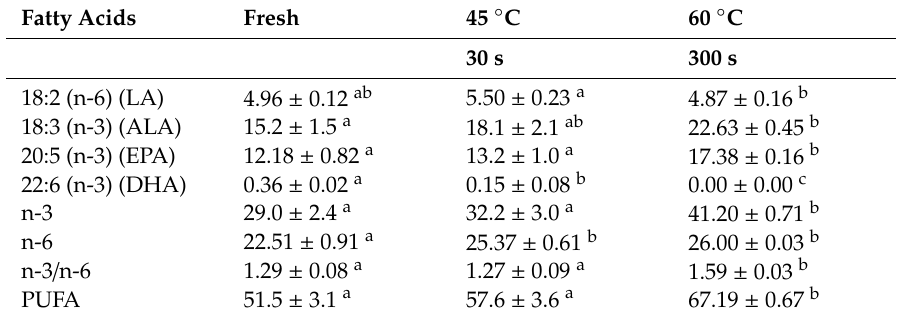
Table 4. Fatty acid composition of fresh and blanched sugar kelp expressed in % FAME. Data are expressed as means ± SD and represents three process replications ( n = 3). The fatty acids are given in % FAME although the ratio (n-3 / n-6) is without